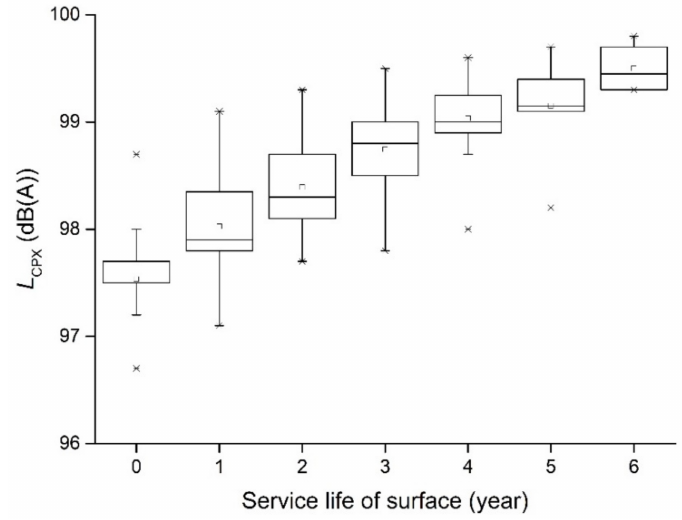
Figure 7. The box plot of tyre/road noise for the EACC 8 surface in each year.